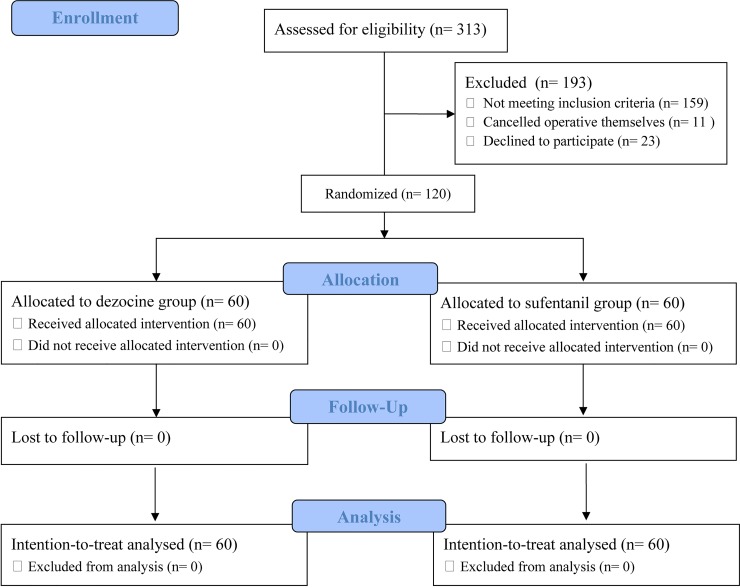
CONSORT flow chart of the study.